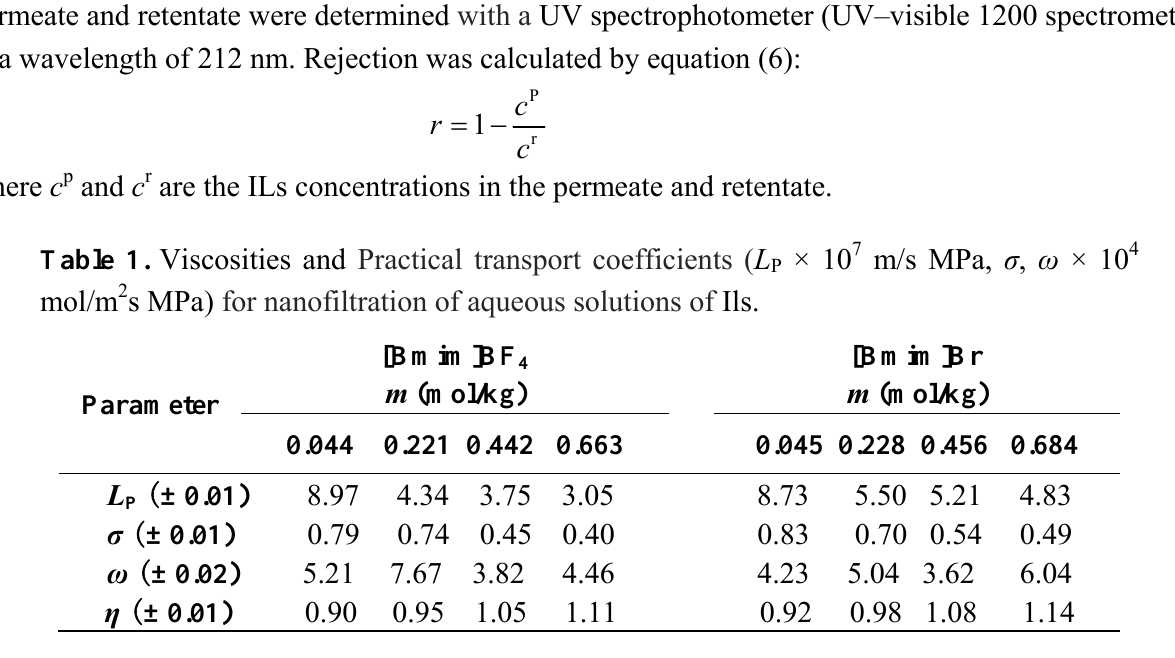
× 10 7 m/s MPa, σ , ω × 10 4 P